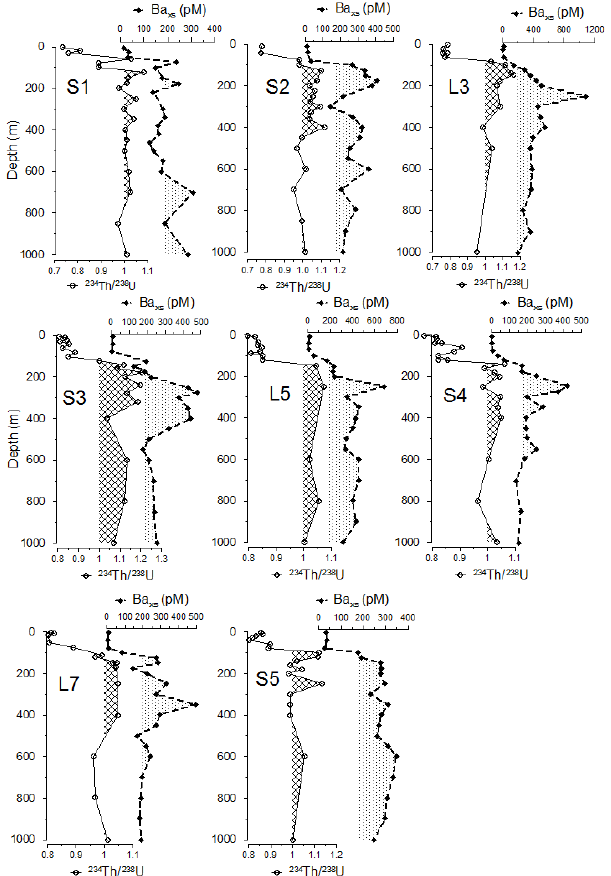
Fig. 2. Vertical distribution of 234 Th/ 238 U ratios and biogenic par- ticulate Ba (Ba xs ; pM) between surface and 1000m depth along the BGH section. Hatched and dotted areas stand for 234 Th excess rel- ative to 238 U and biogenic particulate Ba (Ba xs ) , respectively.